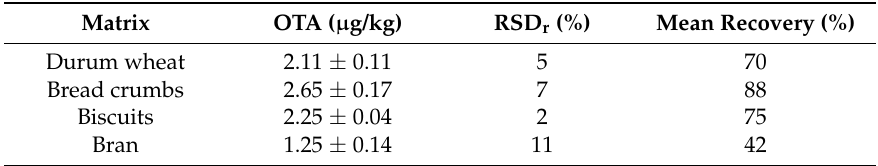
Table 2. Determination of OTA in four cereal-based matrices spiked at 3 µ g/kg ( n = 5) by using DES C a as the extraction